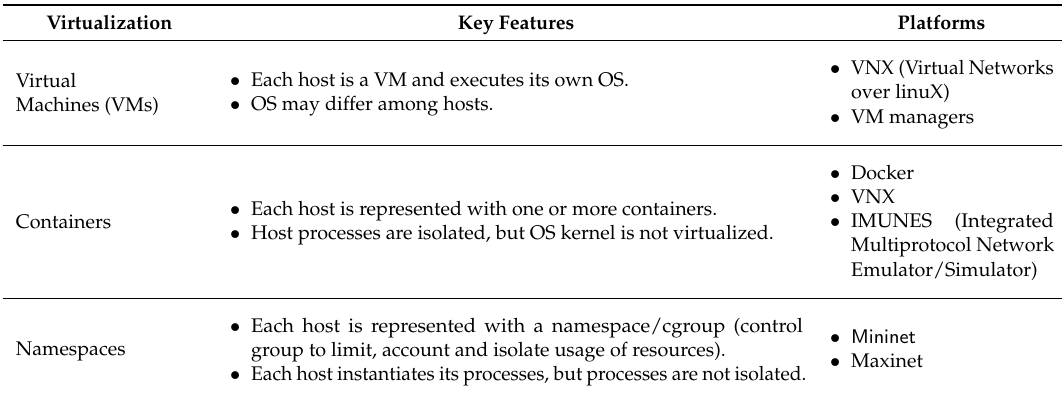
Table 2. Summary of enabling technologies and platforms for the definition of virtual